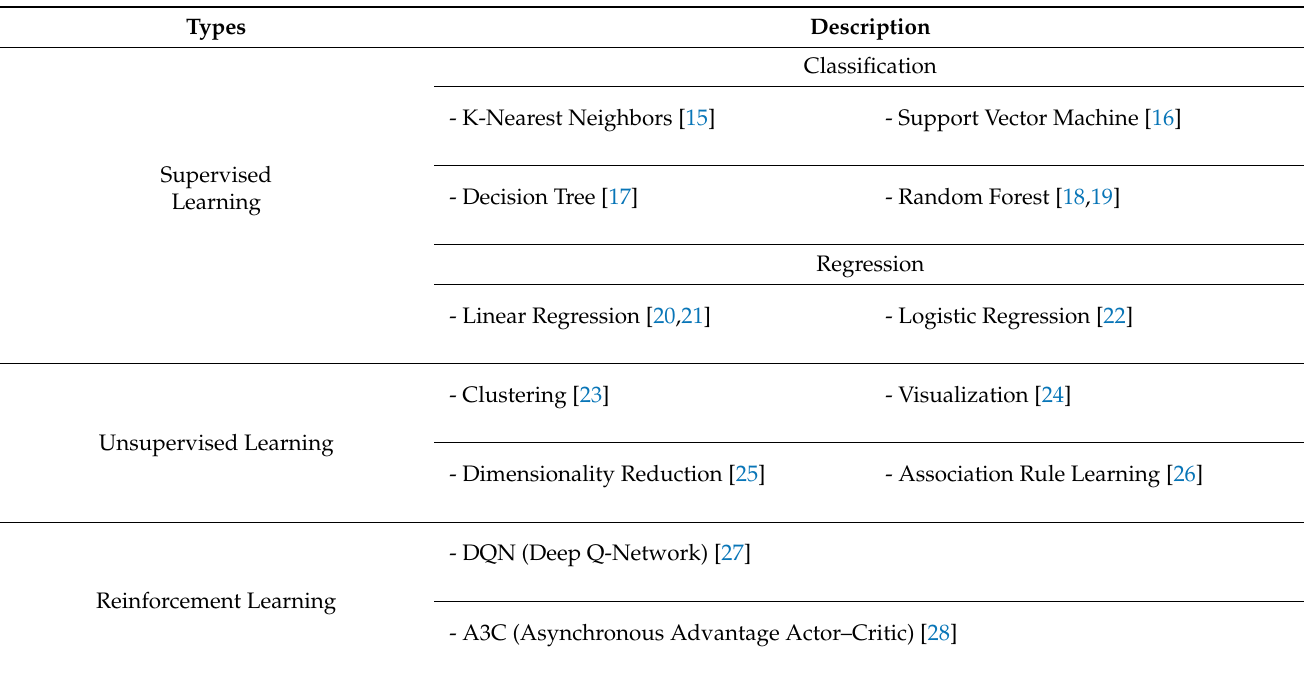
Table 1. Machine learning